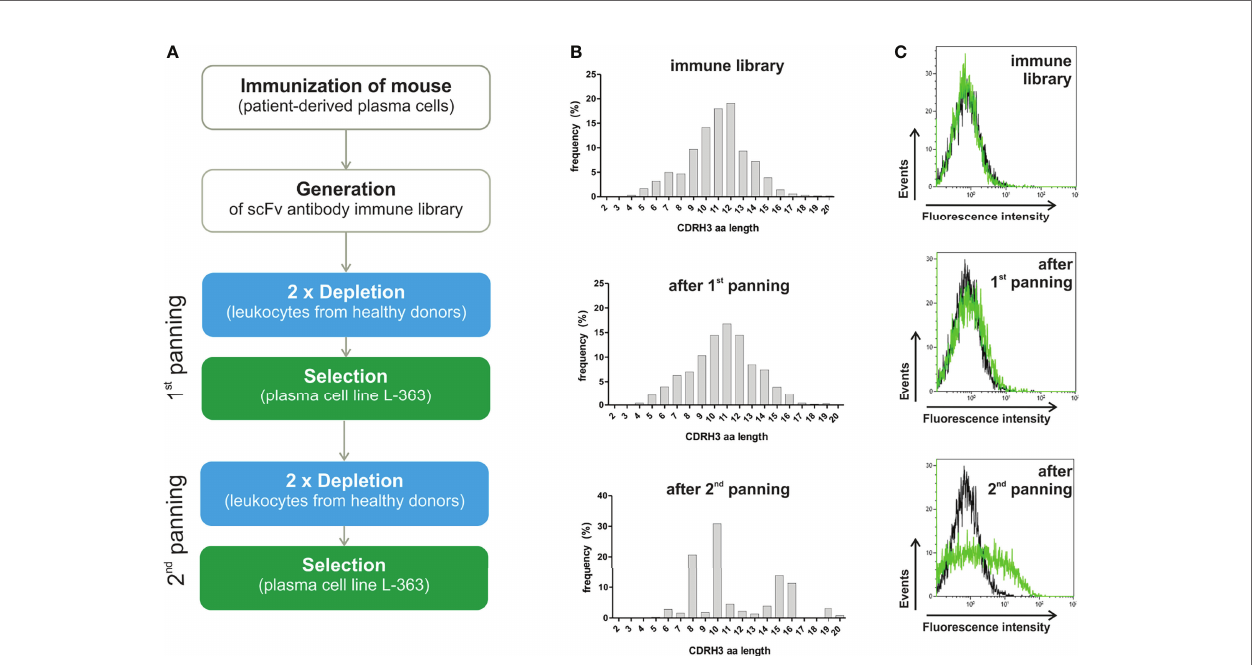
FIGURE 1 | Panning strategy and results of NGS and fl ow cytometry analyses. (A) A scFv antibody library was generated from a mouse repeatedly immunized with PBMC from a PCL patient (95% malignant plasma cells) showing the highest titer of anti-plasma cell antibodies (refer to Supplementary Figure S1 ). Cellular panning to enrich myeloma binding phage antibodies were performed by two-times depletion with leukocytes (blue) and subsequent positive selection on L-363 plasma cell line (green), which was repeated two times. (B) Before and after each panning round, the scFv antibodies were analyzed by NGS to calculate diversity, evenness and dominance ( Table 1 ) and de fi ne the frequency as % of the CDRH3 amino acid (aa) lengths. (C) In addition, fl ow cytometric analyses of the polyclonal phage antibody preparations (green) in comparison to a CD7 binding control phage (black) were performed with L ‐ 363 cells to test for myeloma